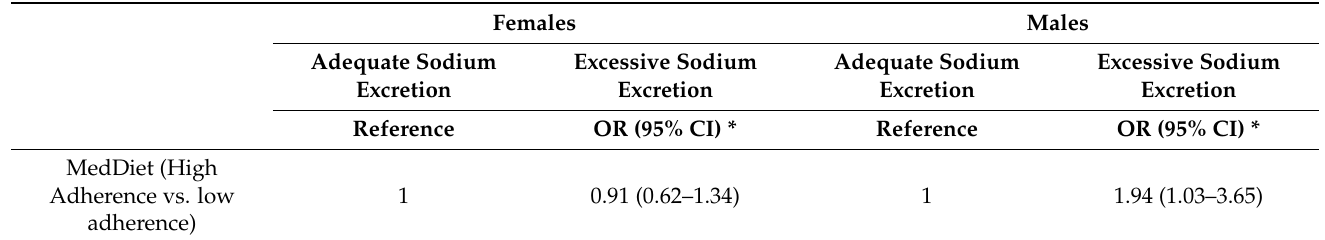
Table 3. Odds ratios for the association between adherence to the Mediterranean Diet and adequacy of sodium excretion in Portuguese